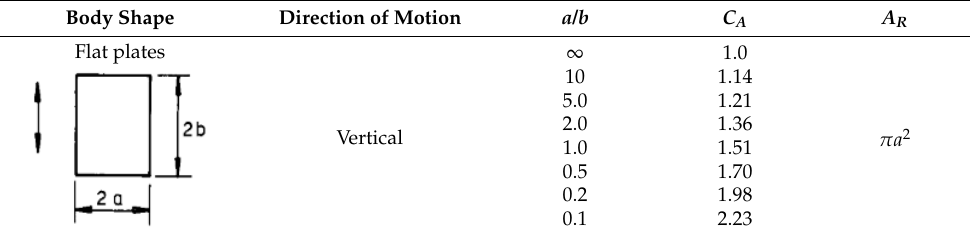
Table A4. Added mass data for the flow parallel to the 2D flat (reproduced from [48], with permission from DNV, 2021).